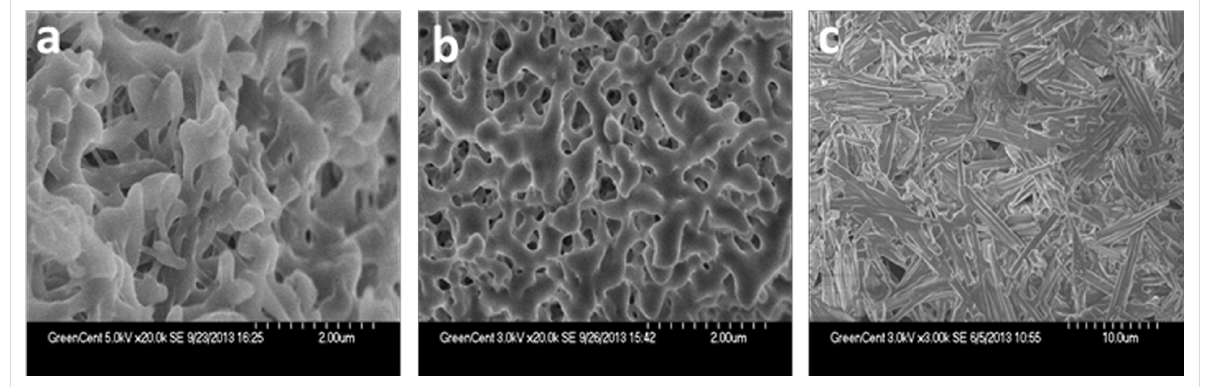
Figure 4: SEM images of xerogels formed with M 6 from solution: (a) ethanol, (b) isopropanol and (c) 1-butanol.